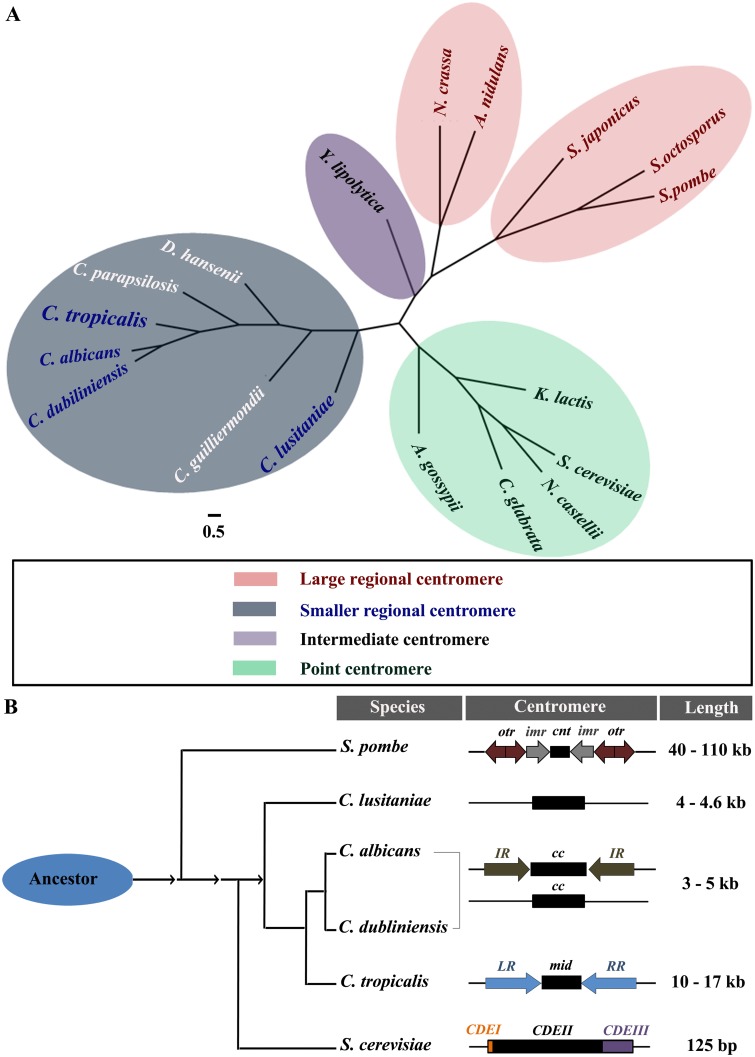
Evolution of centromere organization in ascomycetous fungi.(A) Phylogeny of ascomycetous fungi showing the diverse nature of centromere structure. An unrooted phylogenetic tree was constructed using 573 uniformly evolving orthologous gene families (see methods). The phylogenetic relationship of the species with different types of centromeres is illustrated with colored shadows. The species names shown in white letters designate those with uncharacterized centromeres. The centromeres are mostly point or regional in nature in Ascomycota. However, the centromere of Y. lipolytica is an example of an unconventional intermediate centromere, which shares properties of both point and regional centromere. The centromeres of Y. lipolytica are small (<200 bp in size) and mutations in the partial palindrome lead to centromere dysfunction [96]. These are the characteristics of a point centromere. On the other hand, YlCENs lack the conserved DNA elements (CDEs). Y. lipolytica also does not code for the point centromere specific protein complex (the CBF3 complex) [4]. On the other hand, Y. lipolytica harbors Sim4 and Fta1 proteins, which are kinetochore proteins associated with regional centromere only. Moreover, it should also be noted that the recently identified centromeres of Naumovozyma castellii represent an unconventional class of point centromere with unique centromere DNA elements [97]. See text for the detailed information about the classification of the centromere. (B) Schematic shows a possible route of evolution of structural components of the centromere in ascomycetous yeasts. The length of the centromeres is also mentioned. However, it should be noted that the size of the centromeres in C. albicans, C. dubliniensis and C. lusitaniae is based on the length of the CENP-A binding domain. The inverted repeats of S. pombe and C. tropicalis centromeres aid in CENP-A recruitment de novo. It was also evident from the study in S. pombe that inverted repeats are essential in the establishment of the centromere, but is no longer required for the maintenance of an already established centromere. On the other hand, the centromeres mostly lack pericentric repeats in C. albicans where the role of DNA elements in de novo CENP-A recruitment is unknown. From these lines of evidence, we propose that the pericentric repeats would have been gradually lost in C. albicans and C. dubliniensis. It should also be noted that point centromeres might have originated from the regional ones [98].